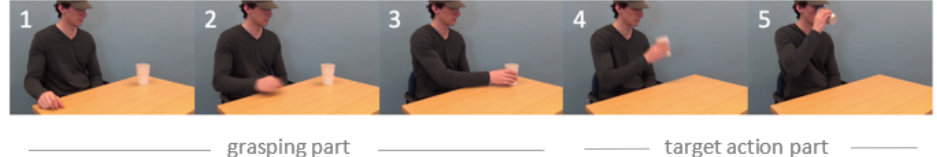
Figure 1. Still frames from an example stimulus video in the drinking condition. Grasp: 1–3, target action (here drink):